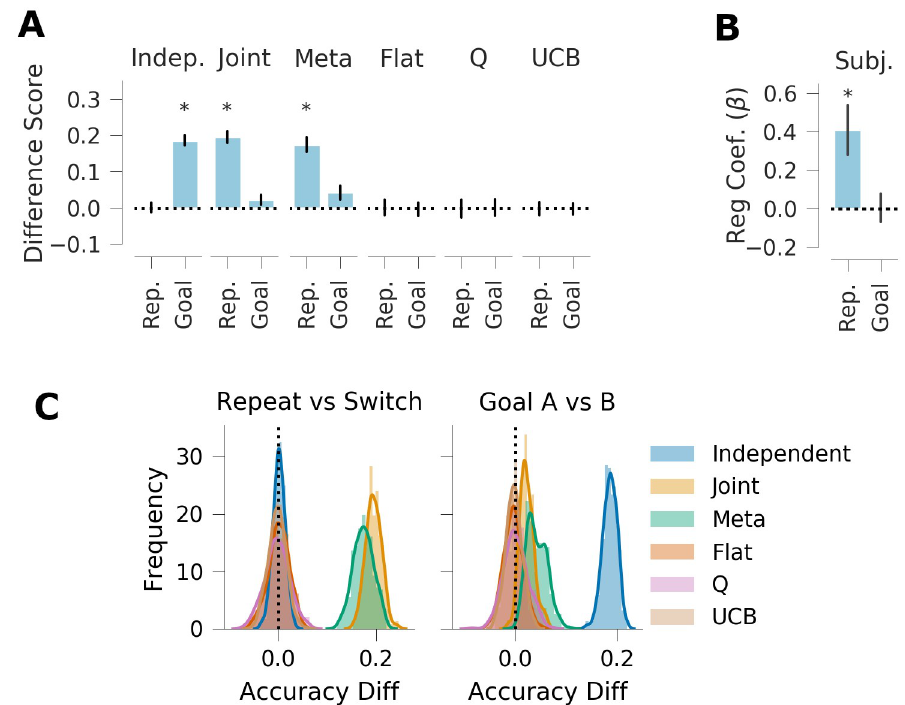
Fig 4. Generalization performance, experiment 1. A : Qualitative model predictions expressed as difference in goal accuracy between the Repeat and Switch test conditions (Rep.) and the difference between test contexts with different correct goals (Goal). B : Human subject data. Regression weights for the between-subjects comparison of goal accuracy in the two test conditions (Rep.) and the within-subjects comparison of test contexts with different correct goals (Goal). C : Histogram of simulated effect sizes in the two comparisons of interest for each of the 6 evaluated models across a range of parameters. Error bars denote standard deviation. trials within a context (S2A Fig; E ½ b � ¼ 0 : 154 , 95% HPD = [0.127, 0.182]) as was their speed t (reciprocal reaction time) ( E ½ b � ¼ 0 : 048 : 95% HPD = [0.002, 0.098]). Navigation (in)effi- t